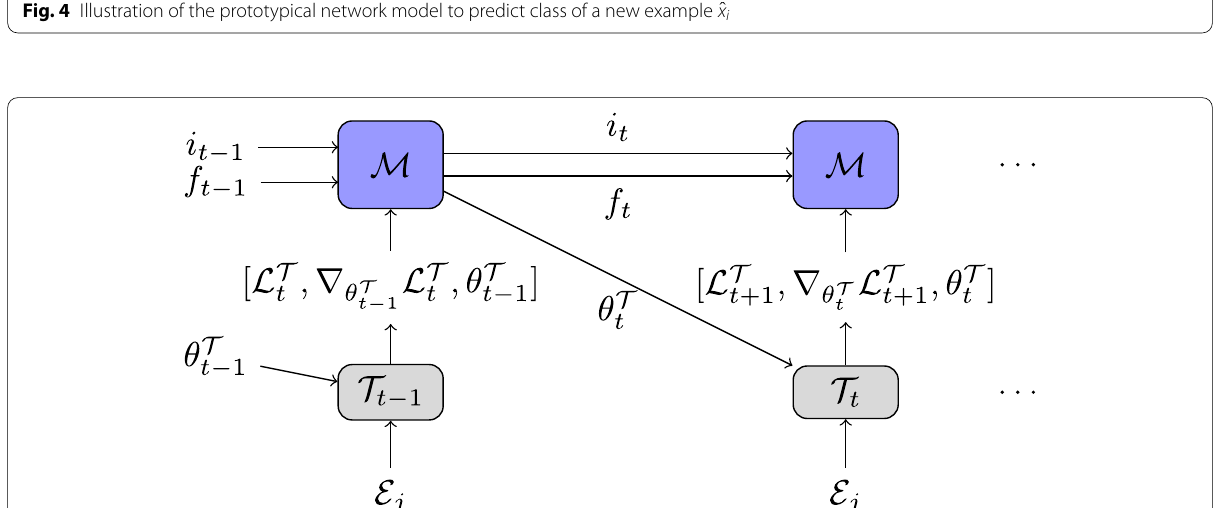
Fig. 5 Illustration of Meta-Learning for training with episode E j at step t . Here the Meta model M processes the different training steps of the trainee T as a